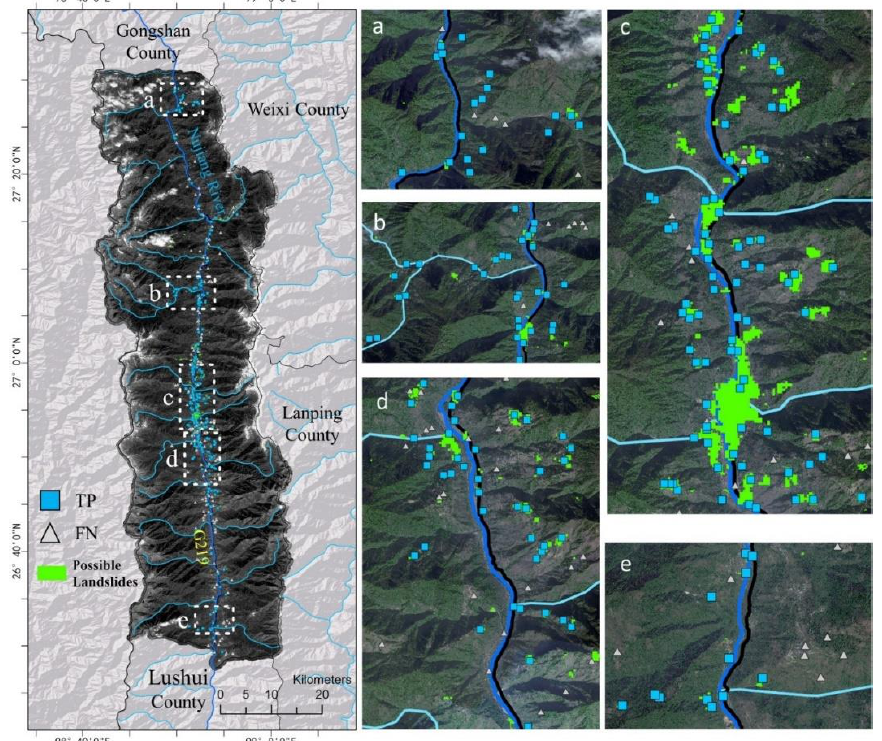
Figure 7. The comparison between possible landslides identified by SBAS-InSAR and references. Here, TP indicates the intersection of SBAS-InSAR landslides and references, while TN indicates the left references not matched with SBAS-InSAR landslides. Here, scatter points having deformation rate > 10 mm/y are considered possible landslides. Panel ( a – e ) are used to display specific regions of the left panel more clearly.